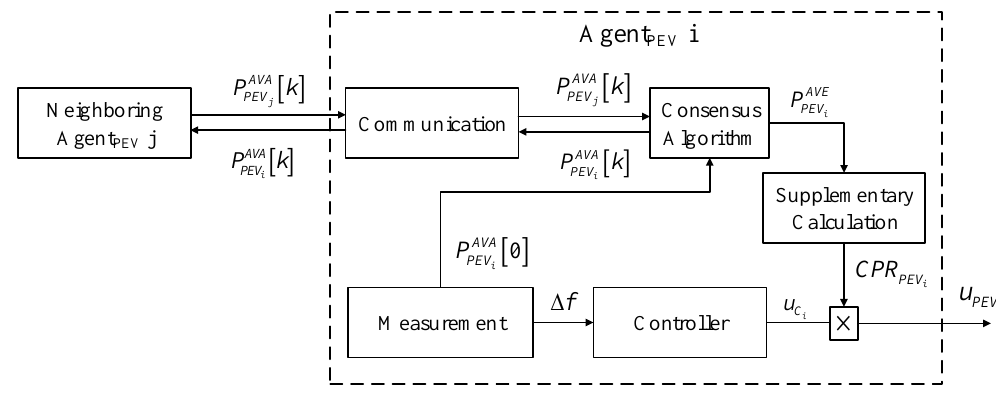
Figure 4. Agent and control structure of the plug-in electric vehicle